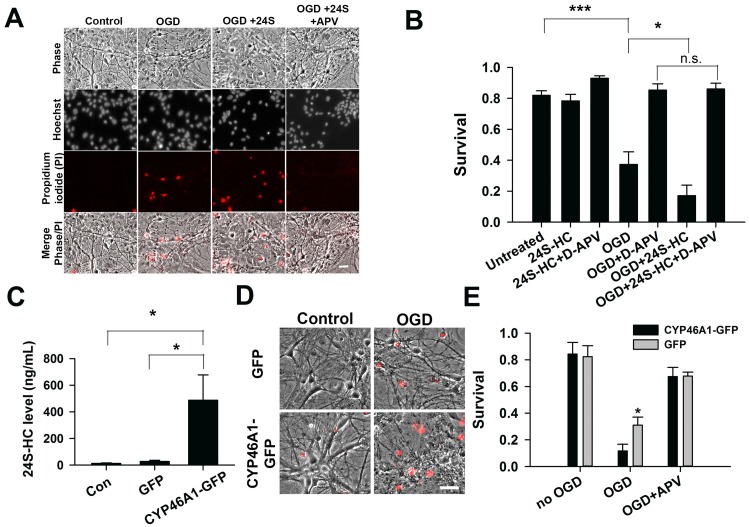
24S-HC exacerbates OGD-induced, NMDAR-dependent cell death.(A) Representative images showing propidium iodide (PI)–labeled, compromised cells in control, OGD, OGD+24S-HC (2 μM), and OGD+24S-HC+APV (50 μM). Scale bar is 30 μm. (B) Survival rate was calculated as number of dead cells normalized to total cells and compared between control, OGD, OGD+APV, OGD+24S-HC, and OGD+24S-HC+APV. Cells treated with OGD and 24S-HC exhibited significantly lower survival rate compared to those treated with OGD alone (n = 7 cultures for each group; one-way repeated measures ANOVA with Bonferroni’s post hoc test, *P < 0.05). (C) 24S-HC levels in the culture media were measured from control (no virus infection), AAV8-GFP, and AAV8-CYP46A1-GFP infected cell cultures (n = 4 cultures for each group; one-way repeated measures ANOVA and Bonferroni post hoc test, *P < 0.05). (D) Representative images showing PI-labeled dead cells in GFP-expressing cells and CYP46A1 GFP-expressing cells with or without OGD challenges. Scale bar is 30 μm. (E) Survival rate was compared between control GFP and CYP46A1 GFP-expressing cells with/without OGD, and with OGD+ APV. Following OGD treatment, CYP46A1 GFP-expressing cells had significantly lower survival rate compared to GFP-expressing cells (n = 5 cultures for each group; two-way repeated measures ANOVA with paired t test, *P <0.05).